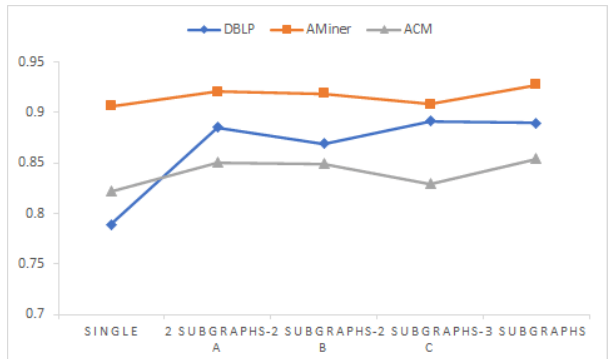
Figure 7. The result of the extended experiment. The number of subgraphs have influence on the